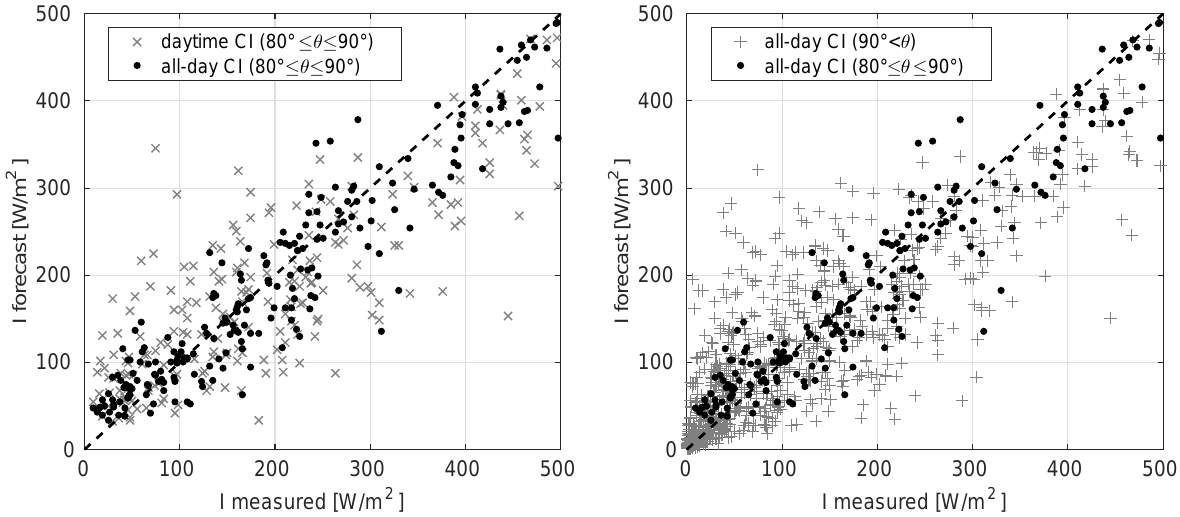
Figure 10. Scatter plot of three-hour CMV forecasts versus global horizontal irradiance I measurement for a single station. ( left ) Forecasts based on daytime only or all-day cloud index, with solar zenith angle 80 ◦ ≤ θ ≤ 90 ◦ at the forecast origin. ( right ) Forecasts based on all-day cloud index with 90 ◦ < θ or 80 ◦ ≤ θ ≤ 90 ◦ at forecast origin. Dataset: single station (World Meteorological Organisation station identifier 094160, at 51.50 ◦ N, 7.78 ◦ E), September 2014–February 2015, hourly